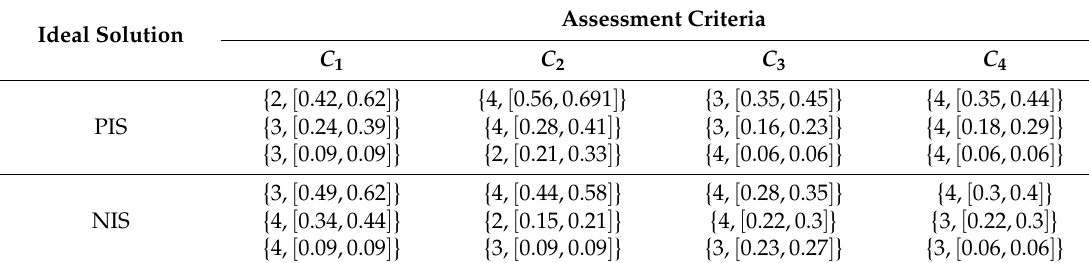
Table 3. Estimation of ideal solution.